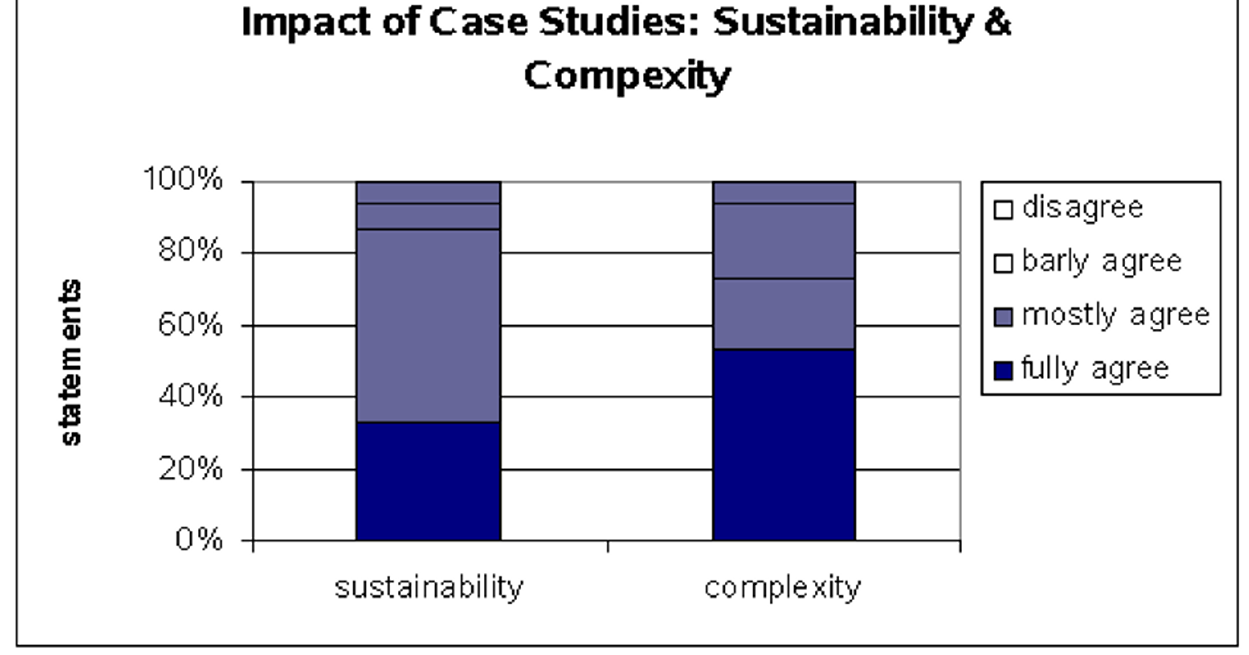
Impact of Case Studies: Sustainability & Complexity Figure 5